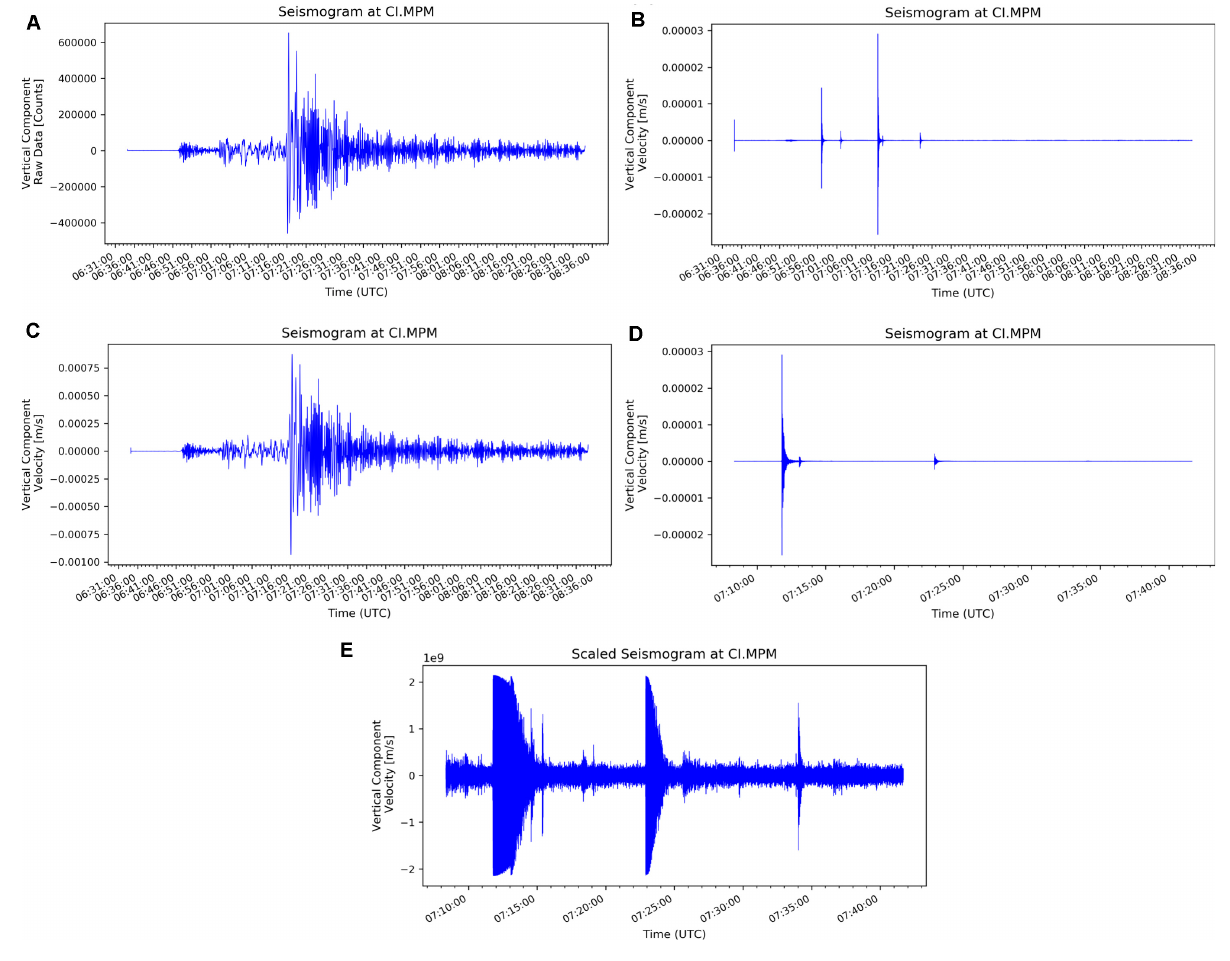
Frontiers in Earth Science |